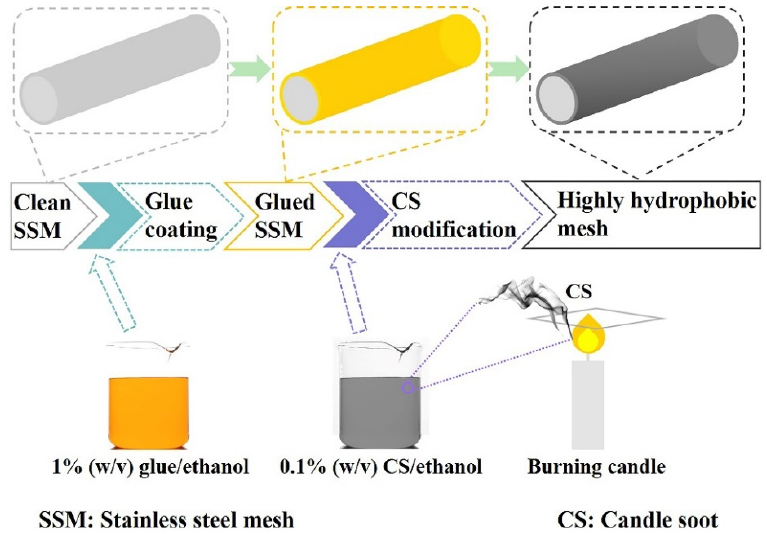
Figure 1. Preparation process of the highly hydrophobic CS-coated